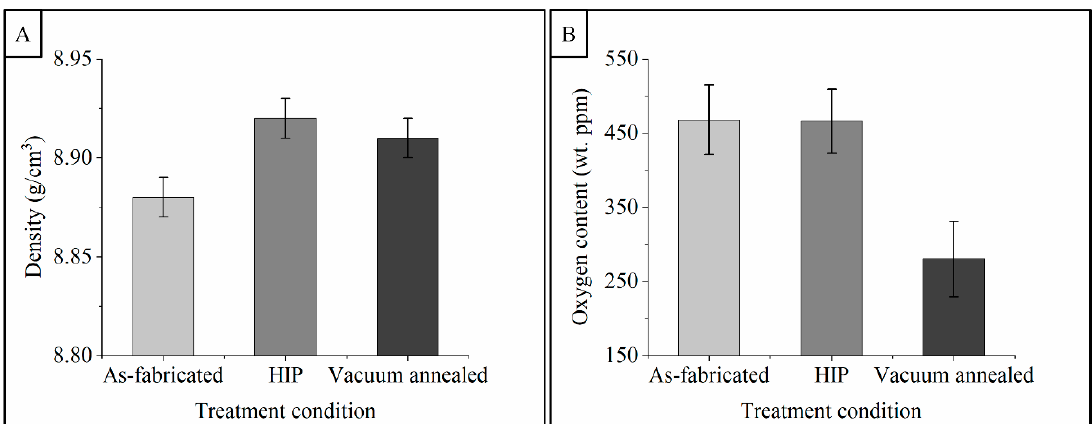
Figure 5. Plots illustrating the effect of treatment condition on the density ( A ) and oxygen content ( B ) of copper produced by EB-PBF. Error bars indicate a 95% confidence interval based on the pooled variance of all samples.